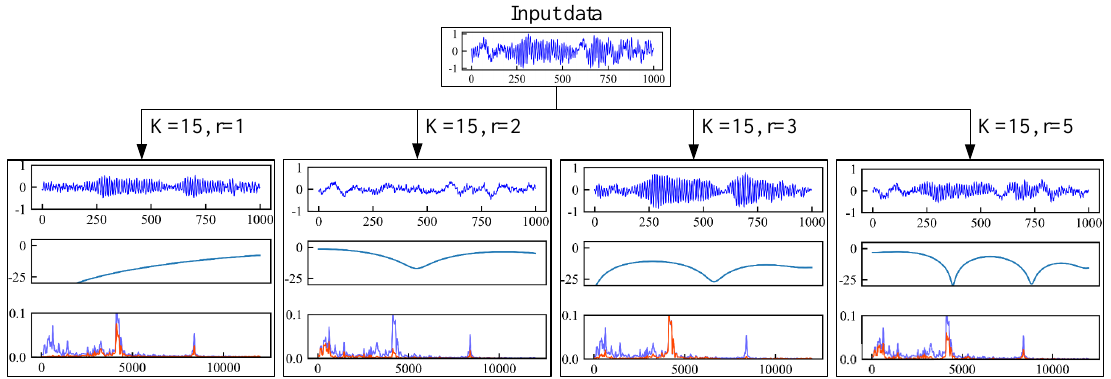
Figure 3. Several typical amplitude-frequency characteristic curves and the signals after convolution without activation function. K is the kernel size, and r is the dilation rate. In the four parallel subgraphs below, the first row is the output of signal after convolution, the second row is the amplitude-frequency characteristics (AFC) curve, and the third row is the FFT spectrogram. In FFT spectrogram, the blue line represents the original signal, the red line represents the output